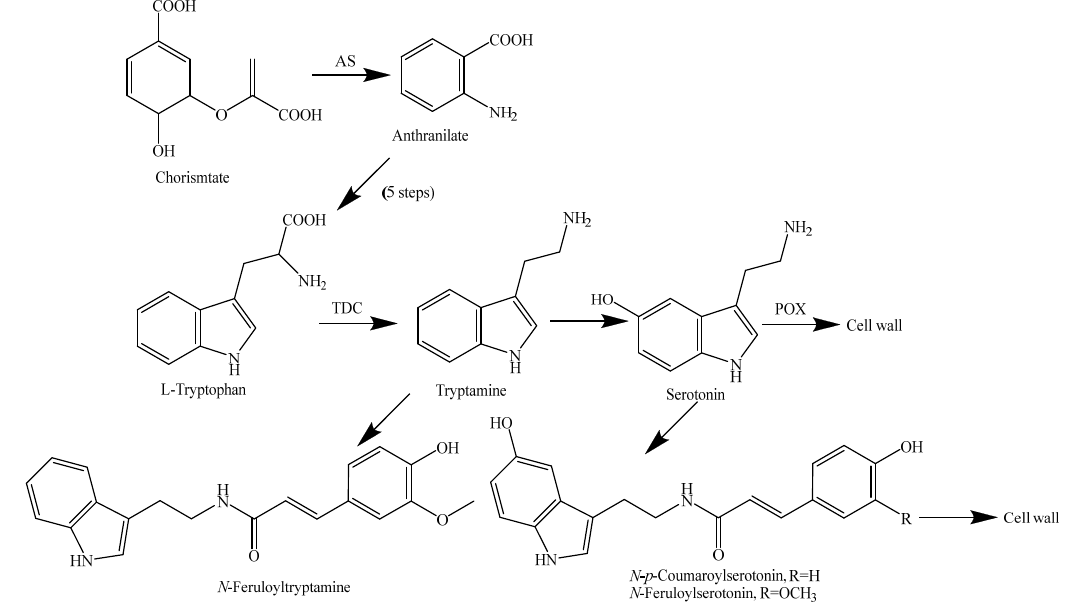
Figure 16. Alkaloid biosynthesis pathways in rice [147]. Abbreviations: AS, anthranilate synthase; TDC, tryptophan decarboxylase; POX, peroxidase.